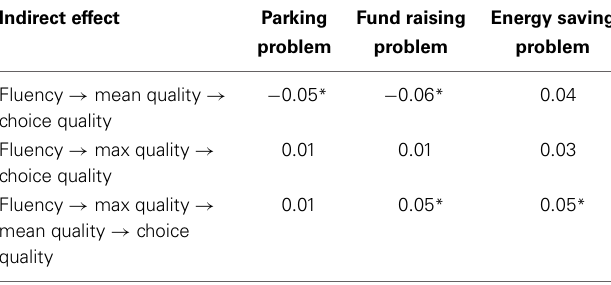
Table 5 | Indirect effects of fluency on choice